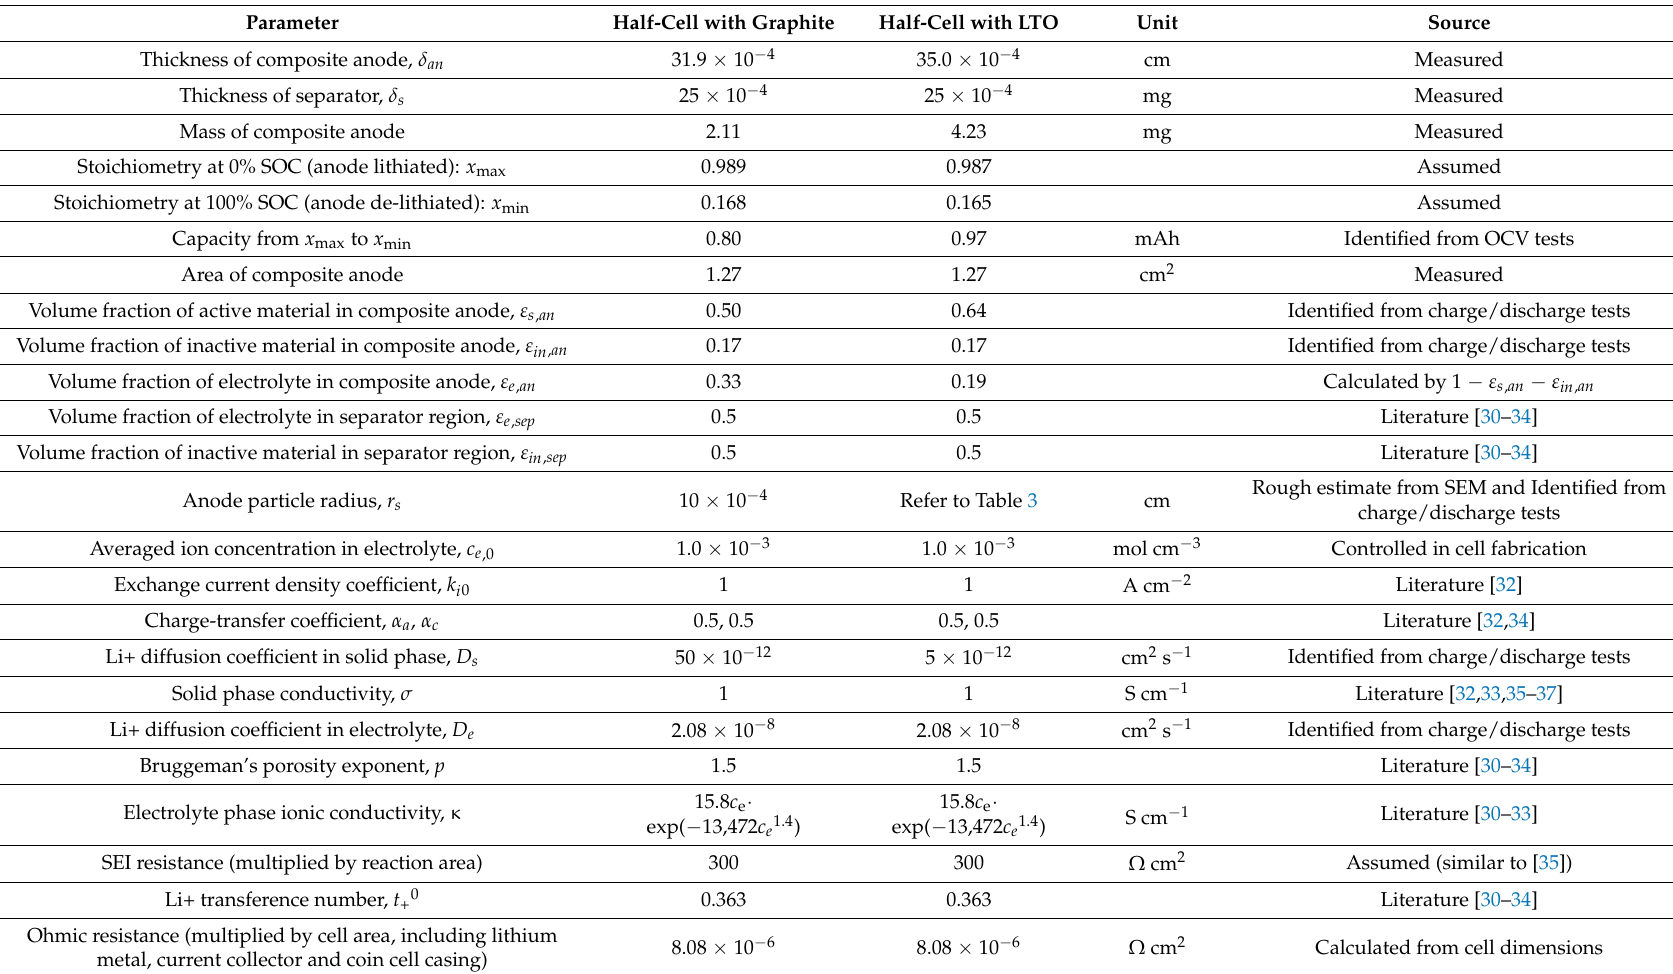
Table 2. Model parameters of graphite and Lithium titanate (LTO) half